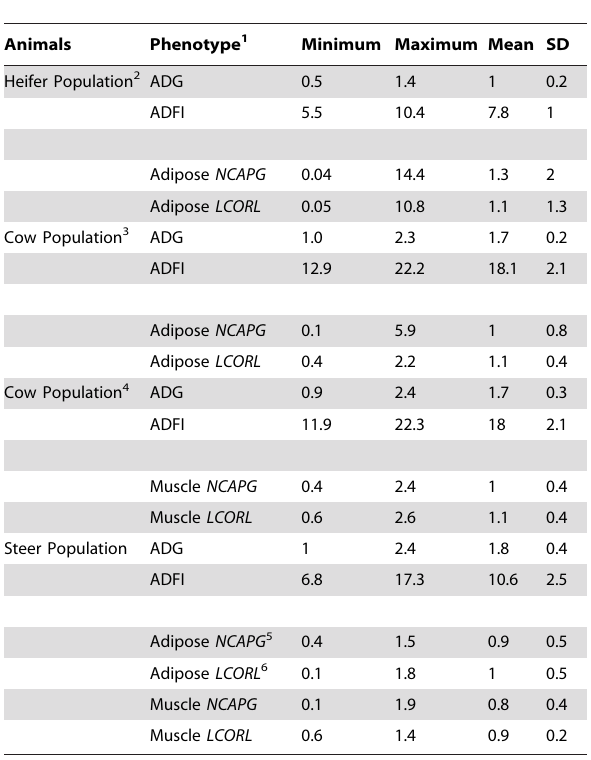
Table 1. Description of phenotypic data from heifers, cows and steers.